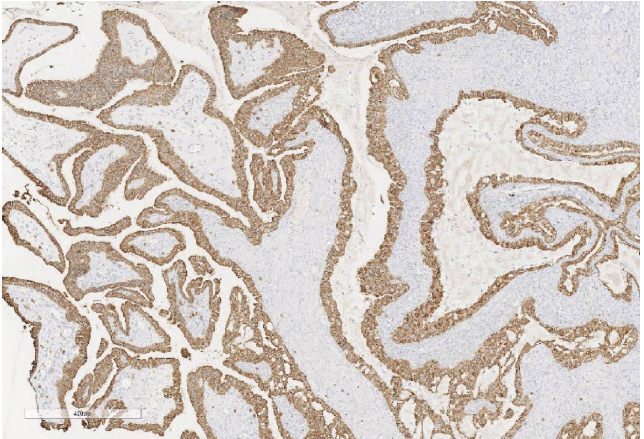
Figure 6: Cytokeratin 7.